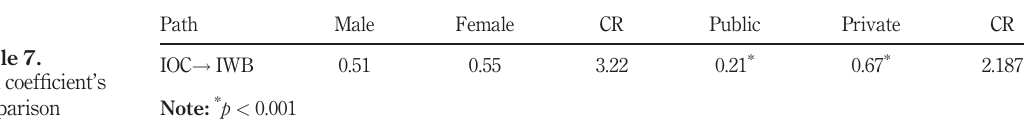
Figure 2. Moderation of work culture